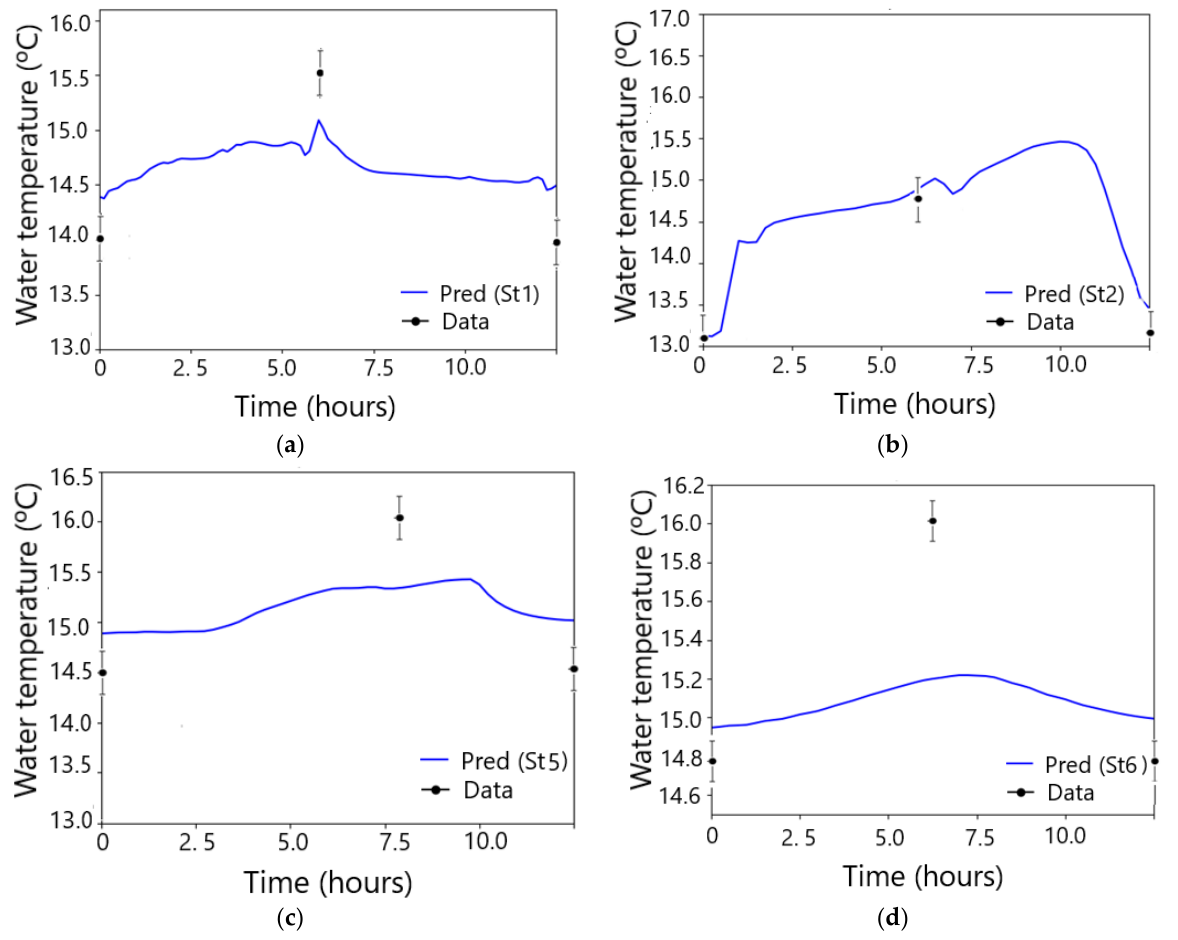
Figure 6. Simulation (line) and data (dot) for the temperature ( a ) — St1; ( b ) — St2(b); ( c ) — St5; ( d ) — St6